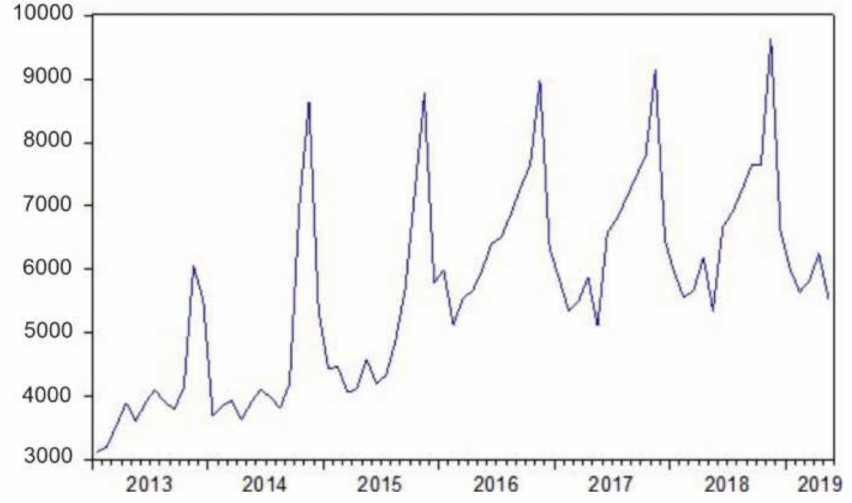
Figure 1. Evolution of the demand for dark tourism in C ó rdoba (January 2013–May 2019). Source. By